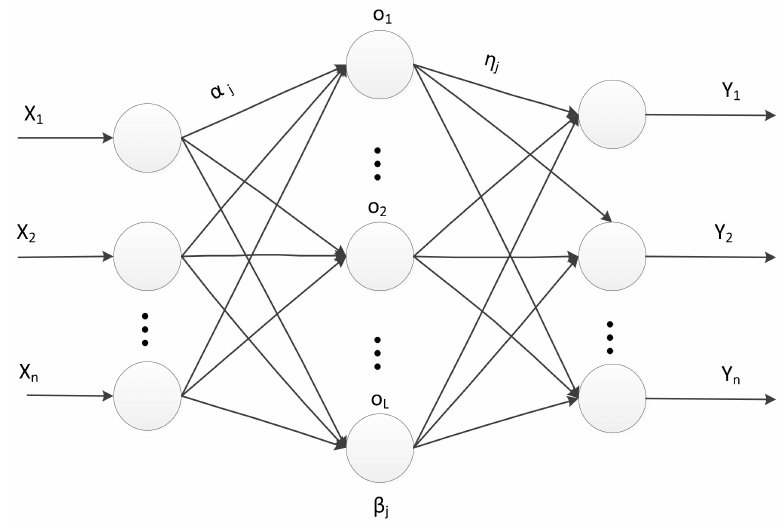
Figure 1. The basic structure of